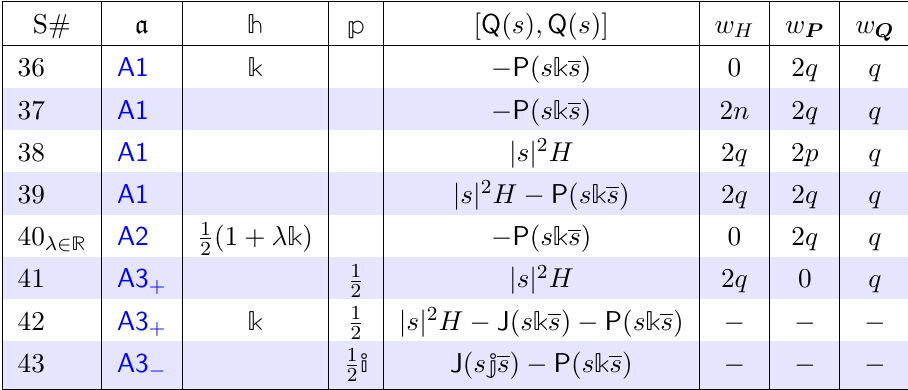
Table 6 . Aristotelian Lie superalgebras (with [ Q ; Q ] 6 =